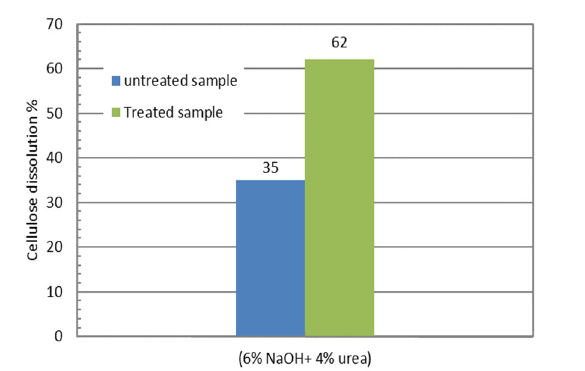
The cellulose fibers dissolution is a thermodynamic process and can be represented by Gibbs free energy equation: ∆ G = ∆ H – T. ∆ S … (1) For cellulose dissolution process (breaking cellulose crystal) by NaOH solution without urea, values of entropy and enthalpy change are -2.23 kJ /mol K and -495.48 kJ /mol respectively. While for the treatment with NaOH and urea, values are -0.546 kJ /mol K and -61.83 kJ /mol respectively [22]. At temperature 258 k (-15 o C), ∆ G=80.55 kJ /mol for treatment without urea and ∆ G=79.01 kJ /mol for treatment with urea. The decrystallization reaction is exothermic because of the negative value of enthalpy so lower temperature is favorable. Figure 11 shows the plot of Gibbs free energy verses temperature for dissolution of cellulose by NaOH solution with and without urea. The two straight lines intersect at temperature 258k (-15 o C). At temperature greater than 258K (-15oC), the treatment with NaOH and urea solution has lower ∆ G than that without urea which is better for decrystallization reaction. While at temperatures less than 258k (-15 o C) NaOH without urea has lower ∆ G so it is better for decrystallization. In the current study the lowest temperature was 253K (-20 o